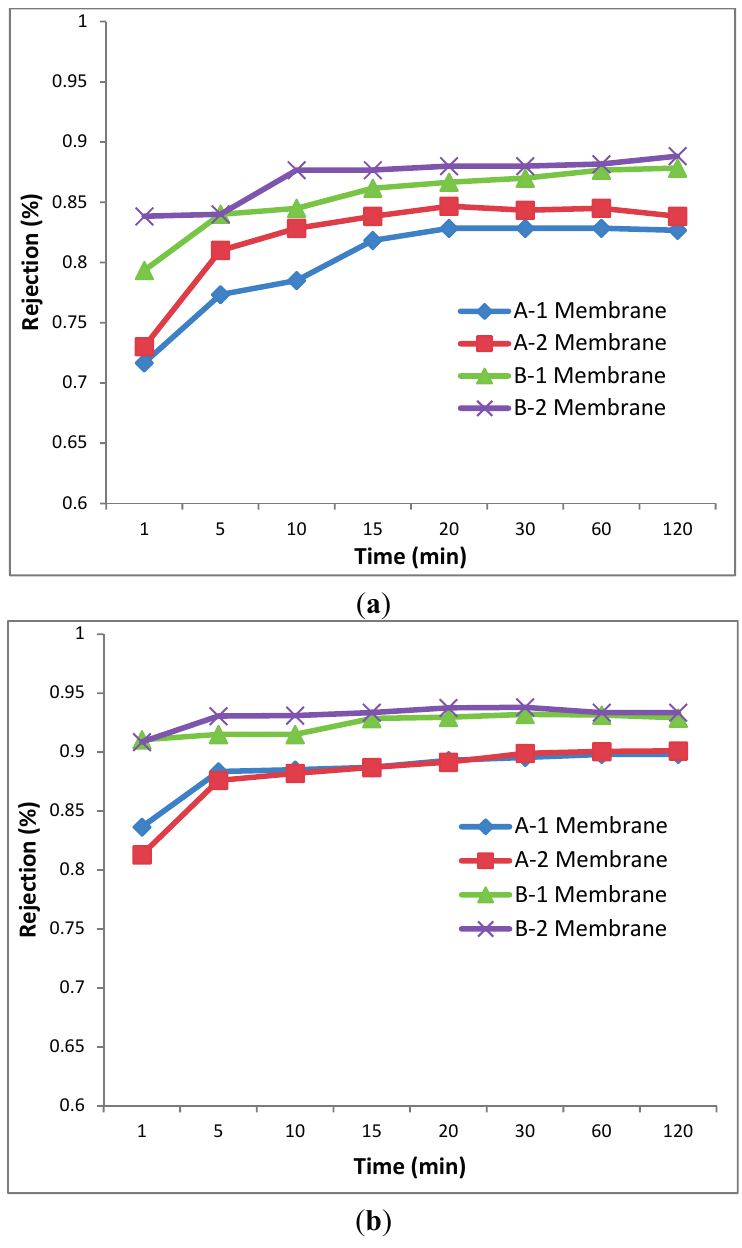
Figure 12. Rejection % of membranes at 6 ppm ( a ) and 20 ppm ( b ) humic